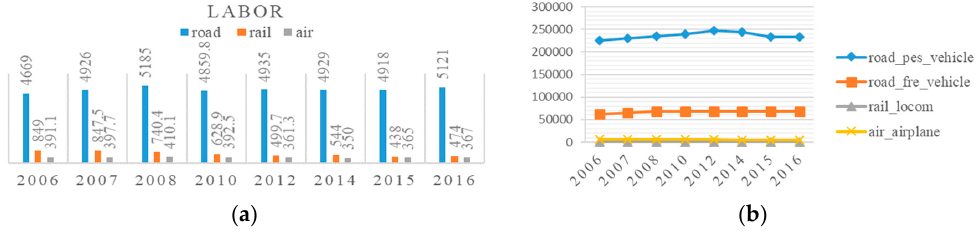
Figure 1. Trends of non-energy inputs for labor ( a ) and ( b ) number of assets.